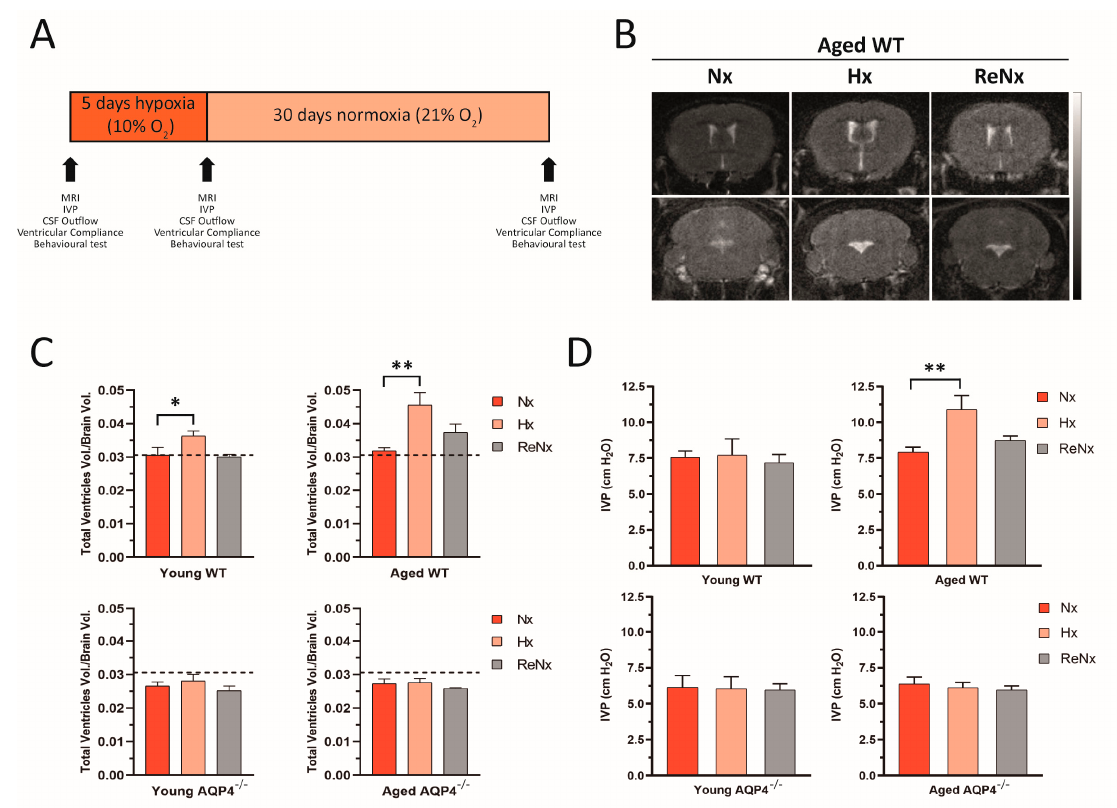
Figure 1. Severe ventriculomegaly in aged wt hypoxic mice is reverted by re-normoxia. ( A ) Diagram showing the experimental protocol followed for each experimental group: wt or AQP4 − / − young and aged mice were subjected to normoxia (Nx: 21% O 2 ); hypoxia (Hx: 5 days at 10% O 2 ); or re-normoxia (ReNx: 30 days at 21% O 2 after Hx); and a physiological analysis and behavioral test were performed (MRI, IVP, CSF outflow, ventricular compliance, and novel object recognition). The time-point of these experimental analyses is indicated by arrows. ( B ) MRI of brain coronal sections from aged wt mice in Nx, Hx, and ReNx. The gradient scale of T2-weighted MRI indicates the liquid present in the tissue, ranging from bright (high water content) to dark (absence of water). ( C ) Quantification of ventricular volume of each experimental group under the conditions described in ( A ). ( D ) Analysis of IVP measurements recorded in the four study groups, under the conditions mentioned above. Data are presented as mean ± SEM. Number of animals analyzed for each experimental condition: Young-wt, Nx ( n = 12); Hx ( n = 11); ReNx ( n = 6). Aged-wt, Nx ( n = 5); Hx ( n = 6); ReNx ( n = 6). Young-AQP4 − / −